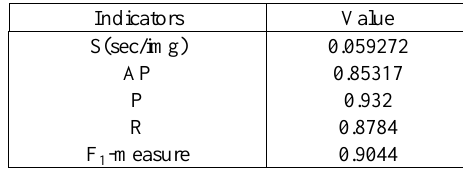
Table 3. Quantitative results of model testing